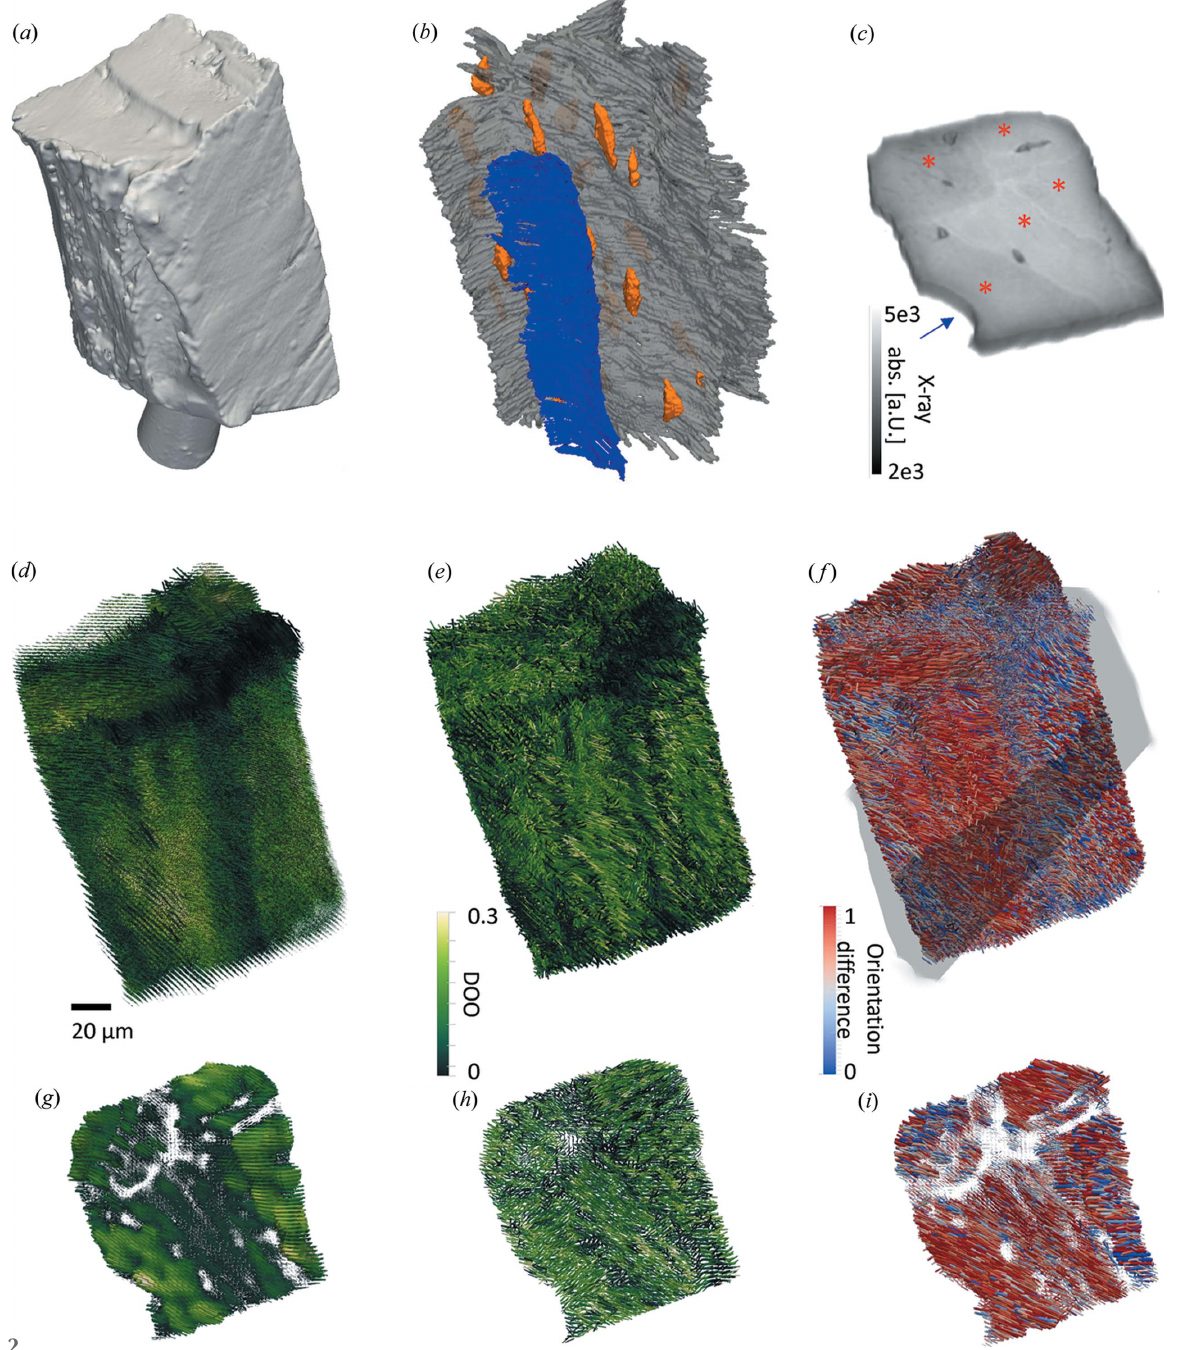
Figure 2 3D tomograms. ( a ) Surface rendering of the sample from synchrotron absorption tomography. ( b ) Segmentation of structural components based on the synchrotron absorption tomography data. Blue = blood vessel surface, orange = lacunae, gray = cement lines. ( c ) Slice through the absorption tomogram, showing the cement lines separating the different bone compartments (indicated by red asterisks) and the location of the central blood vessel (blue arrow). ( d ) SAXS tensor tomography. ( e ) WAXS tensor tomography. ( f ) Comparison of SAXS versus WAXS orientation, with the orientation difference calculated as the squared dot product color-coded with 1 (red) for co-orientation of mineral and nanostructure as in the classical models, and 0 (blue) for maximum orientation difference, gray outline indicates slice location for ( g ) and ( h ). ( g ) Slice through the SAXS orientation tomogram. ( h ) Slice through the WAXS orientation tomogram. ( i ) Slice through the SAXS versus WAXS orientation comparison